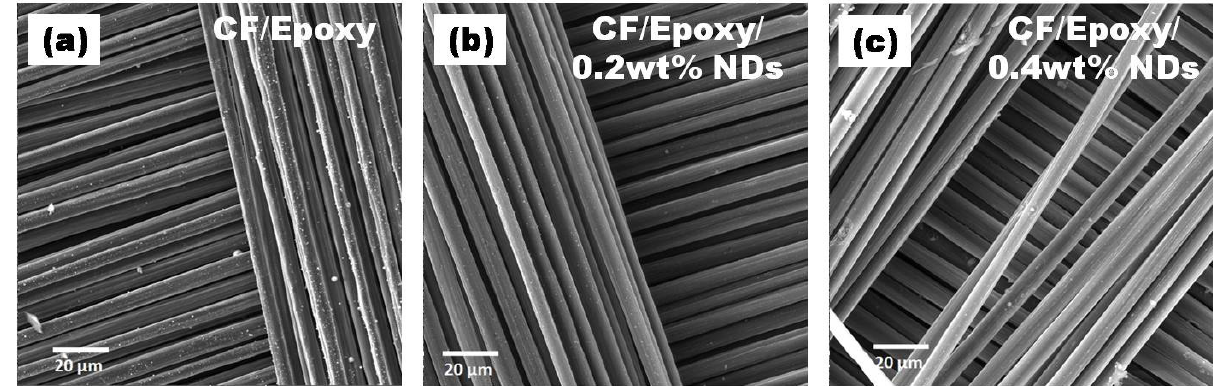
Figure 15. Magnified SEM images of CFRE-Cs 7 mm away from flame hit point where ( a ) CF/Epoxy, ( b ) CF/Epoxy/0.2 wt% NDs and ( c ) Cf/Epoxy/0.4 wt% NDs.